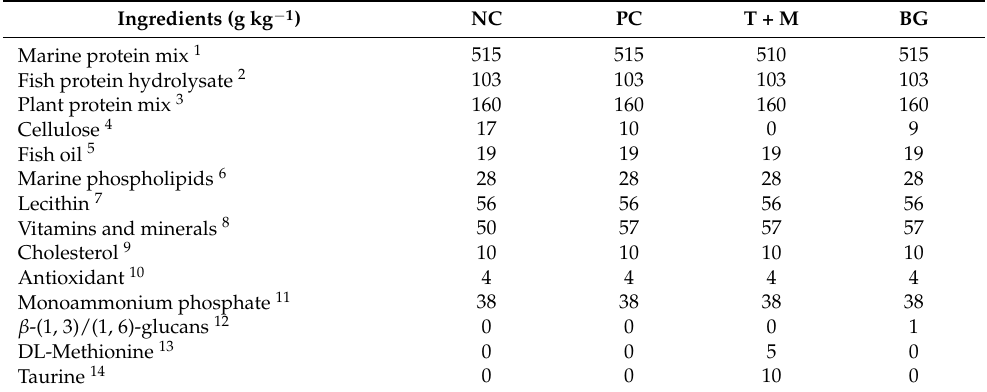
Table 1. Dietary formulation of the experimental diets used to culture whiteleg shrimp ( P. vannamei ) PL for 18 days.